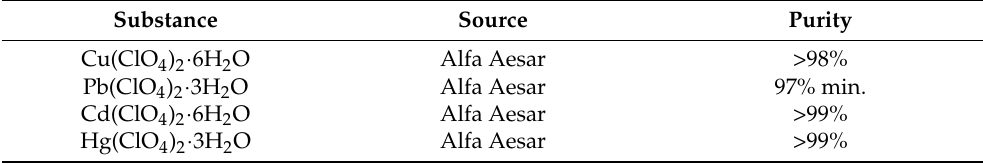
Table 2. Heavy metal salts used for the complexation study with Na 4 BRA and Na 4 SRA.